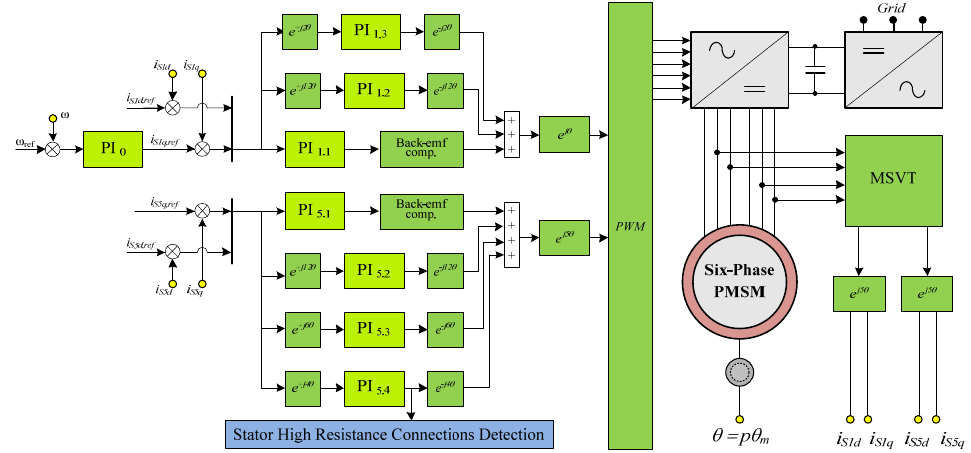
Figure 2. Block scheme of the proposed control strategy, with the capability to detect and tolerate a high resistance connection (HRC) fault.